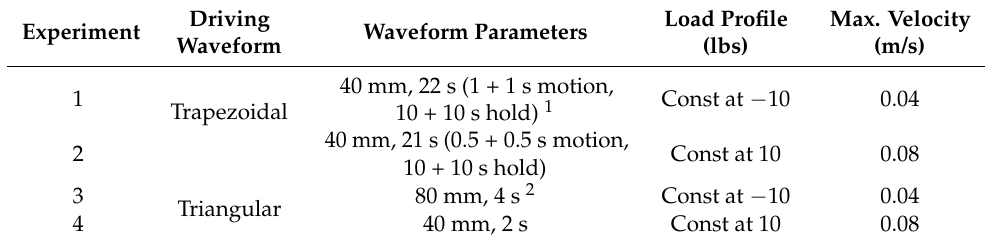
Table 1. Description of the case study dataset.